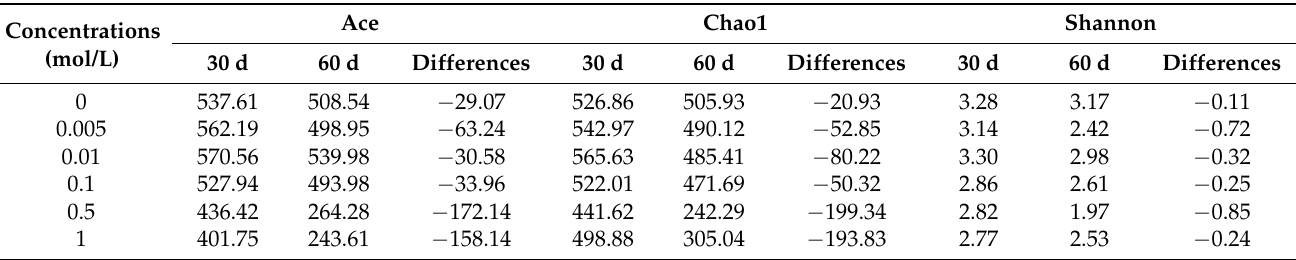
Table 3. Effect of catechol on fungal